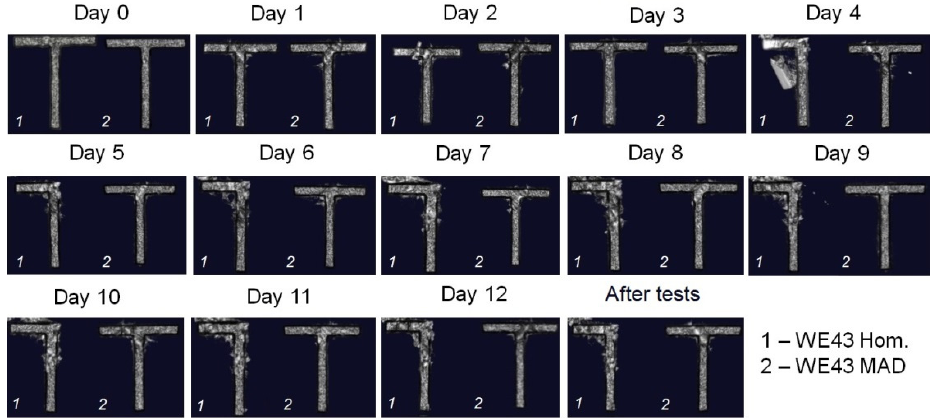
Figure 5. Degradation of WE43 alloy samples in the initial and MAD-modified states during incu- bation in FBS (the immersion medium was changed daily). tion in FBS (the immersion medium was changed